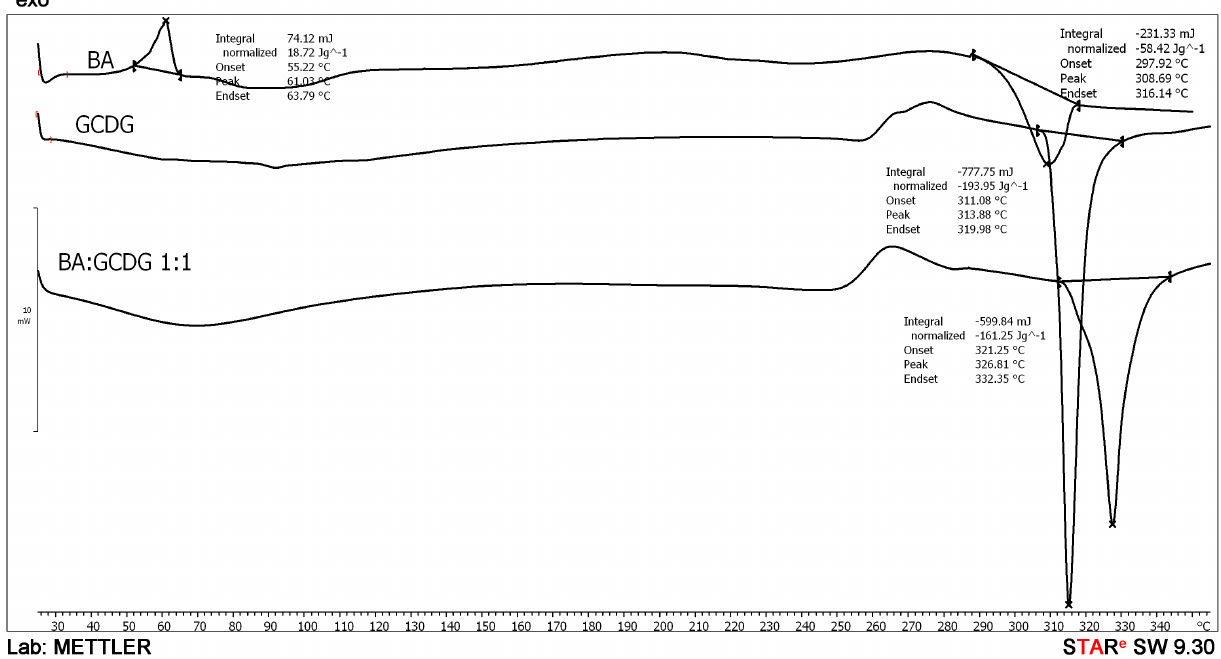
Figure 3. Differential scanning calorimetry (DSC) curves of BA, octakis-[6-deoxy-6- (2-sulfanyl ethanesulfonic acid)]- γ -cyclodextrin (GCDG) and their 1:1 complex. As